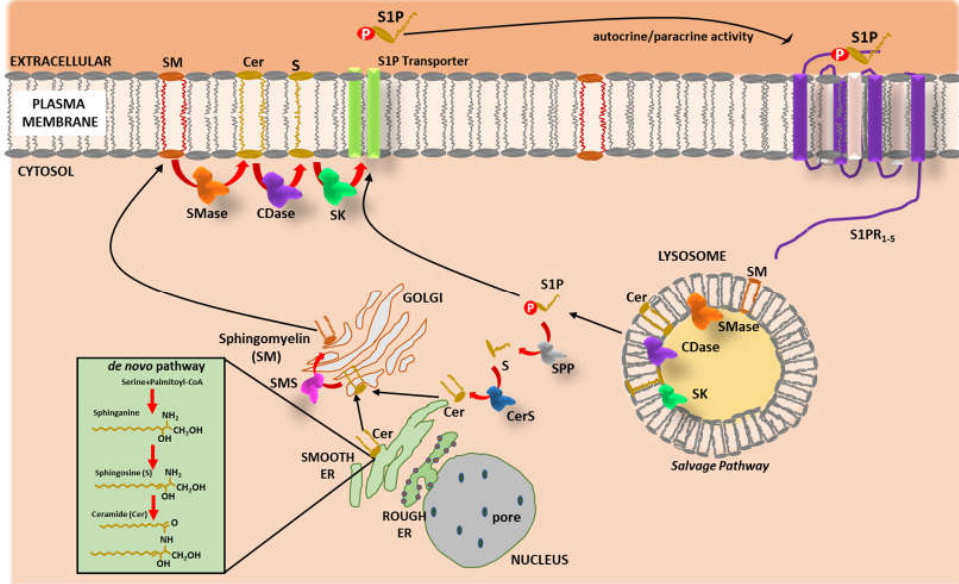
Figure 1. Schematic representation of sphingolipid metabolism. The de novo synthesis pathway begins in the cytosolic leaflet of the smooth endoplasmic reticulum (ER). It starts with the condensation of palmitoyl coenzyme A (CoA) and serine, followed by several enzymatic reactions (red arrows) leading to the formation of sphinganine, sphingosine (S) and then ceramide (Cer). Once generated, Cer is transported to the Golgi apparatus where it is converted to sphingomyelin (SM) by SM synthase (SMS). SM is then transported to the plasma membrane where under specific condition/stimulation, SM can be reconverted in Cer by sphingomyelinase (SMase) that is further transformed into S and with the help of sphingosine kinases (SKs) is phosphorylated, thus leading to the generation of the bioactive lipid S1-phosphate (S1P) that is transported outside the membrane. Of note, the production of S1P is also possible in the lysosomes (salvage pathway) where SM is converted into Cer and then S. The S1P generated in this pathway can be either transported outside the cells or is reconverted into S by S1P phosphatase (SPP). S is finally transformed into Cer by Cer synthase.